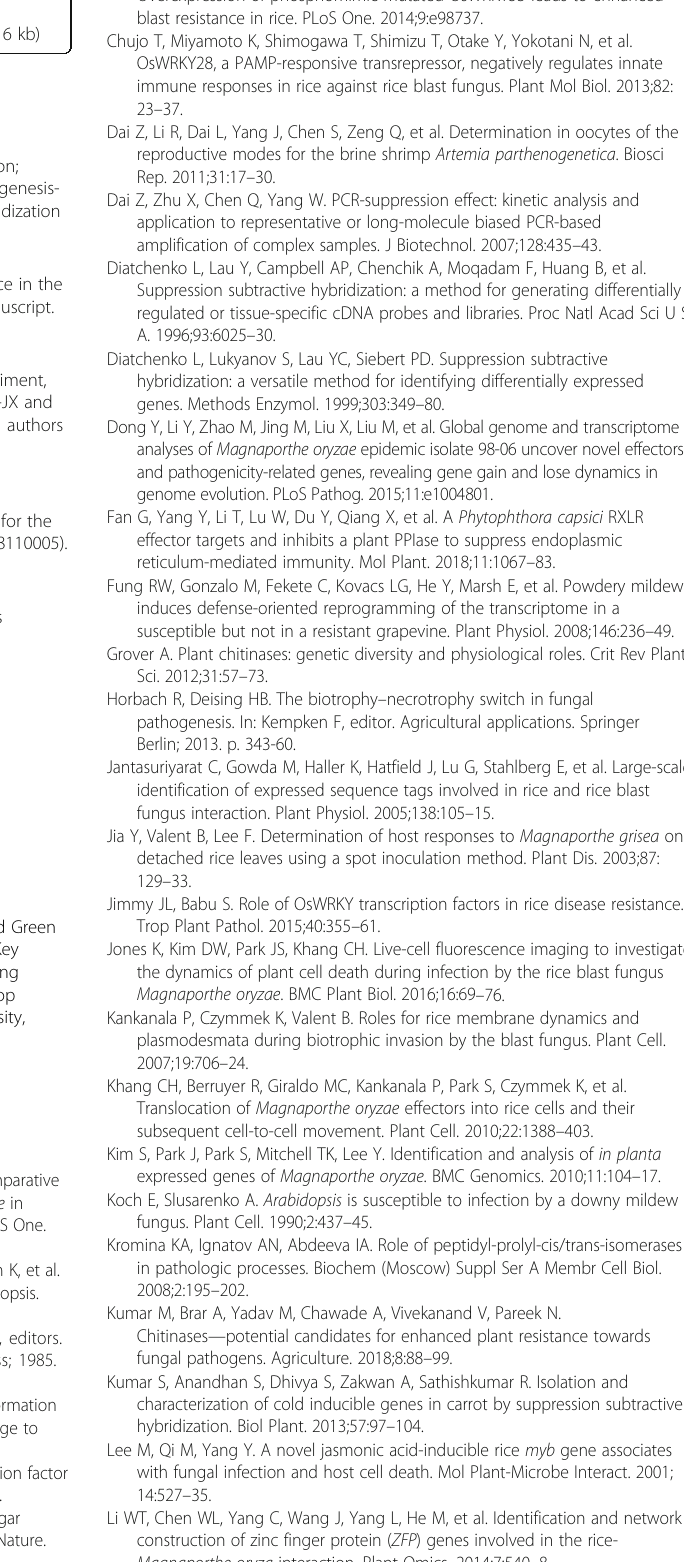
Additional file 6: Table S2. Oligonucleotides used in this study. (DOCX 18 kb) Additional file 7: Table S3. Plasmids used in this study. (DOCX 16